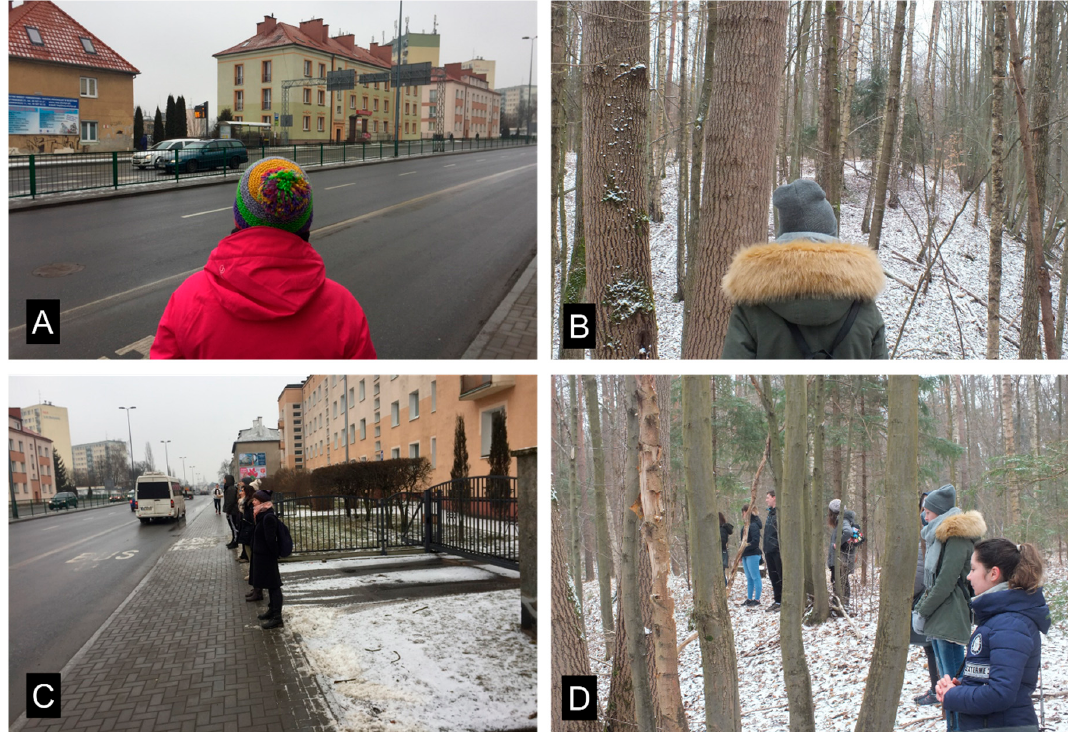
Figure 2. Photos showing the urban ( A ) and forest ( B ) views used for the viewing session. Photos of the research group during viewing sessions in the urban street environment ( C ) and forest environment ( D